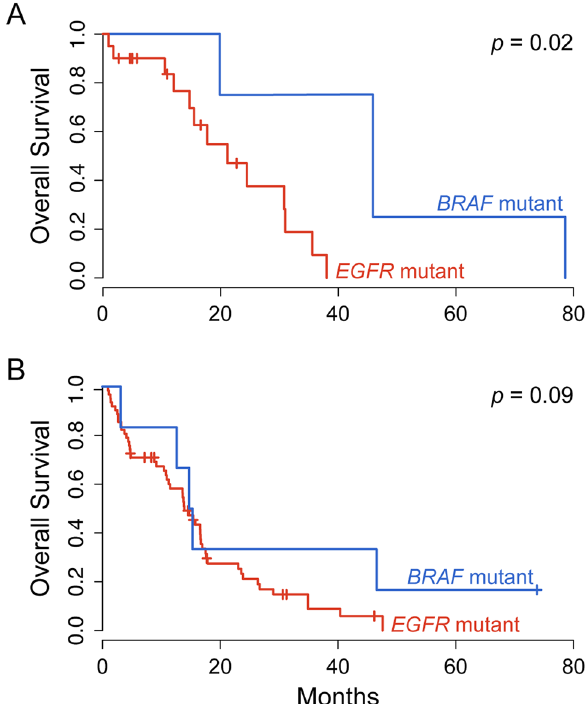
Figure 3. The impact of BRAF versus EGFR mutations on overall survival in glioblastoma. Kaplan–Meier plots indicate the difference in survival between BRAF and EGFR mutated tumors in our in-house cohort ( A ) and a dataset from TCGA ( B ). Considering only IDH1 wild-type tumors, the average overall survival of three patients with putative activating BRAF mutations was longer than that of 20 patients with EGFR mutations from the in-house cohort (average overall survival of 48.01 ± 24.42 months versus 16.13 ± 11.46 months, respectively; log-rank p = 0.02). One patient with an activating IDH1 mutation and another with a BRAF frameshift mutation (likely loss-of-function) were omitted from this analysis. Likewise, the average overall survival of 6 patients with gain-of-function BRAF mutations was longer compared to 77 patients with gain-of-function EGFR mutations in a cohort from TCGA (average overall survival of 27.68 ± 26.95 and 14.19 ± 11.28 months, respectively; log-rank p =